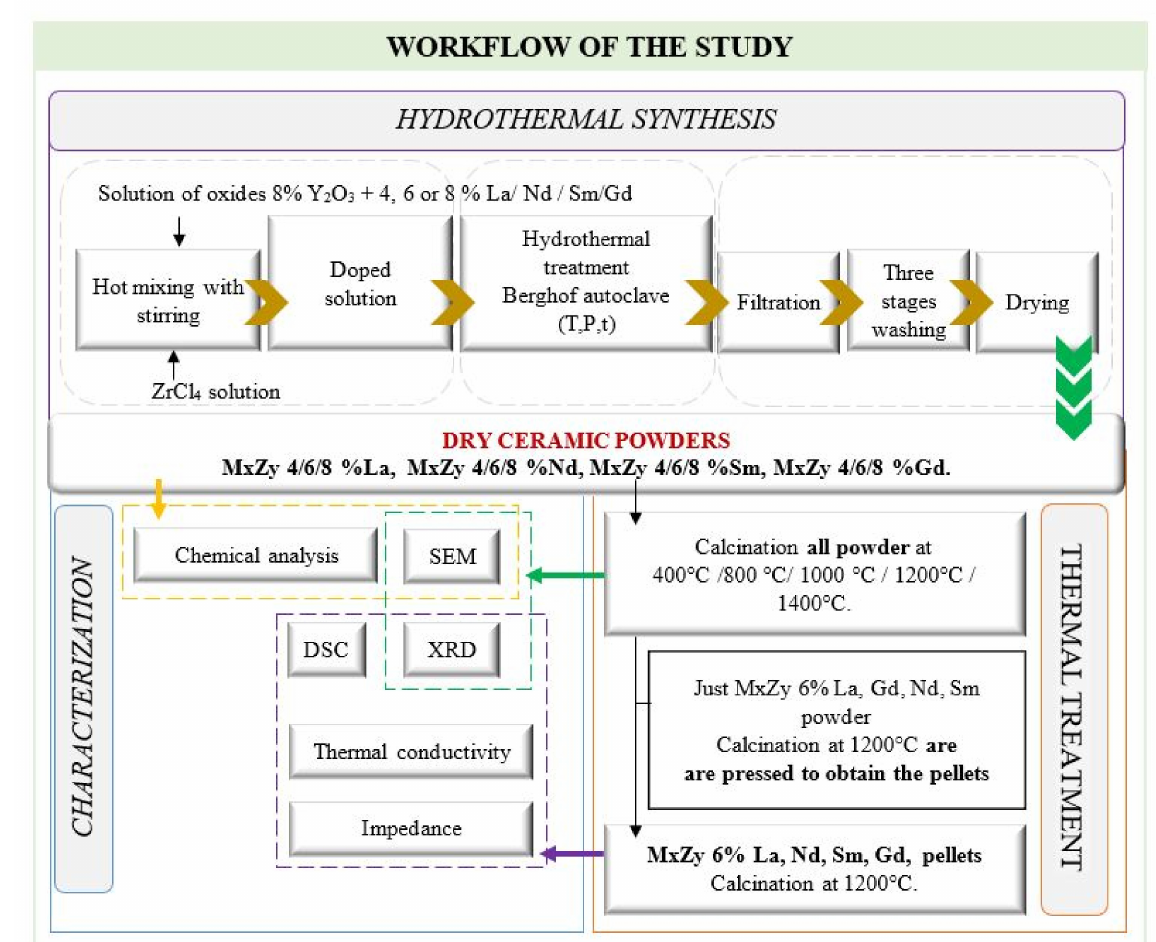
Figure 2. Schematic workflow of the